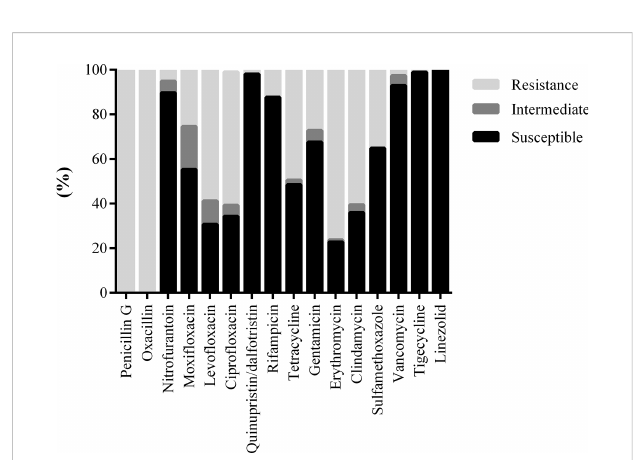
FIGURE 2 Drug sensitivity results of MRS from diabetic foot